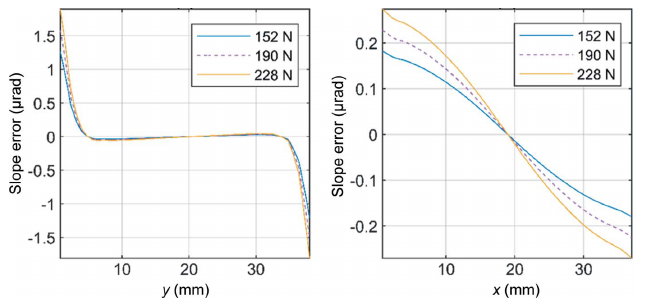
Figure 3 Slope errors across the centre line of the optical surface of the crystal in the ( a ) sagittal direction and ( b ) meridional direction.